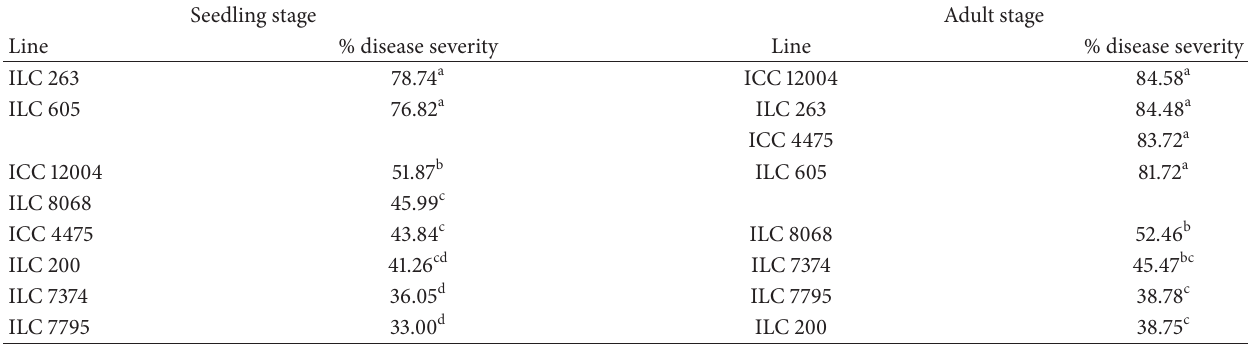
Table 4: Ranking of chickpea lines to Ascochyta blight.